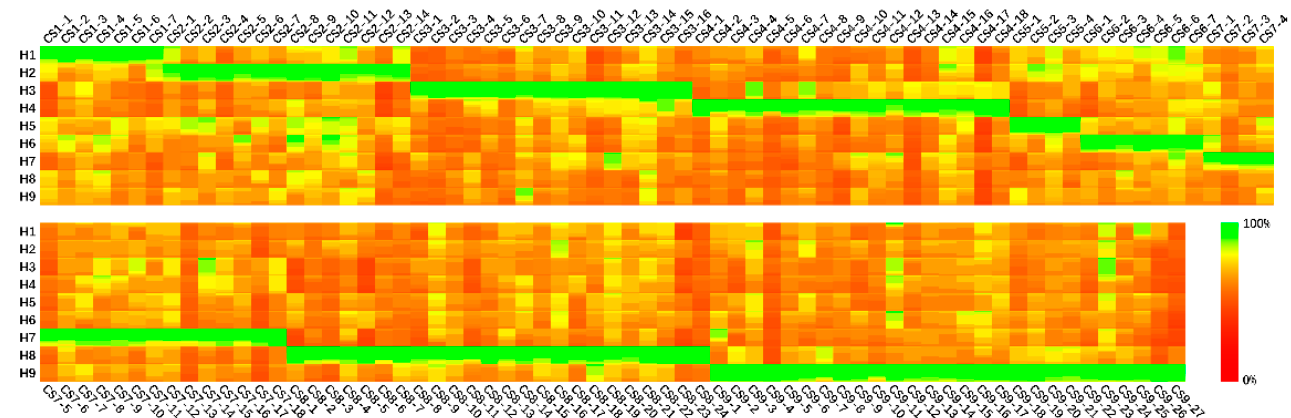
Figure 2. Nucleotide conserved sequence matching in H1–H9 subtypes. The matching of each nucleotide conserved sequence with each subtype is shown in 100 × 100 pixel squares, and each pixel represents an equal proportion of samples. Base matching of 100% is expressed in green (RGB010) and 0% base matching in red (RGB100). Row names are labelled by HA subtype, and column names are labelled by conserved sequences name: CS (conserved sequence) + HA subtype + order. The conserved sequences are cut to a proper length to fit the PCR primer design.